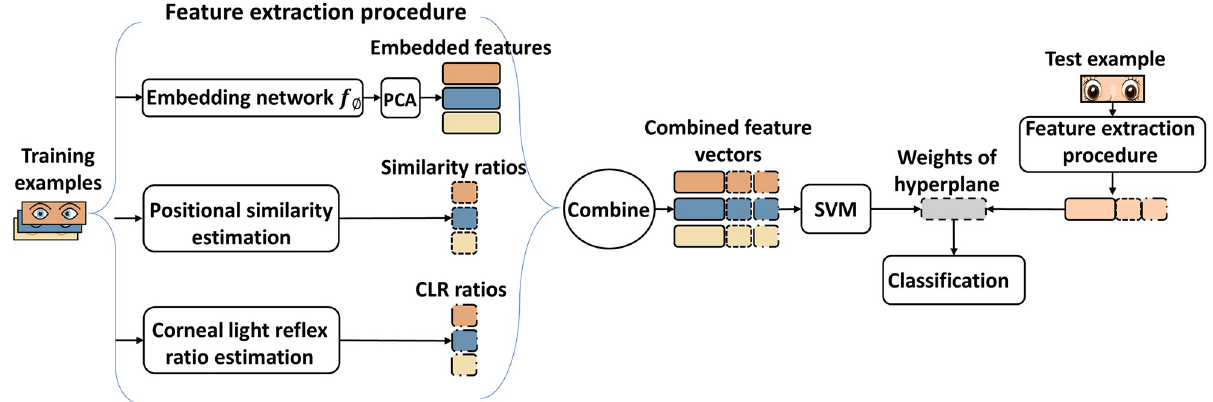
Fig 1. The proposed method for strabismus screening. The eye region training samples are sent to a pre-trained embedding network f significant features and subsequently are passed through principal component analysis to obtain low-dimensional embedded features. Simultaneously, position similarity estimation and corneal light reflex ratio estimation module are applied to the eye region samples to extract position information of eye regions. The information is combined with the embedded features to enrich the representational ability of features (to gain more information about the eye region) before training a support vector